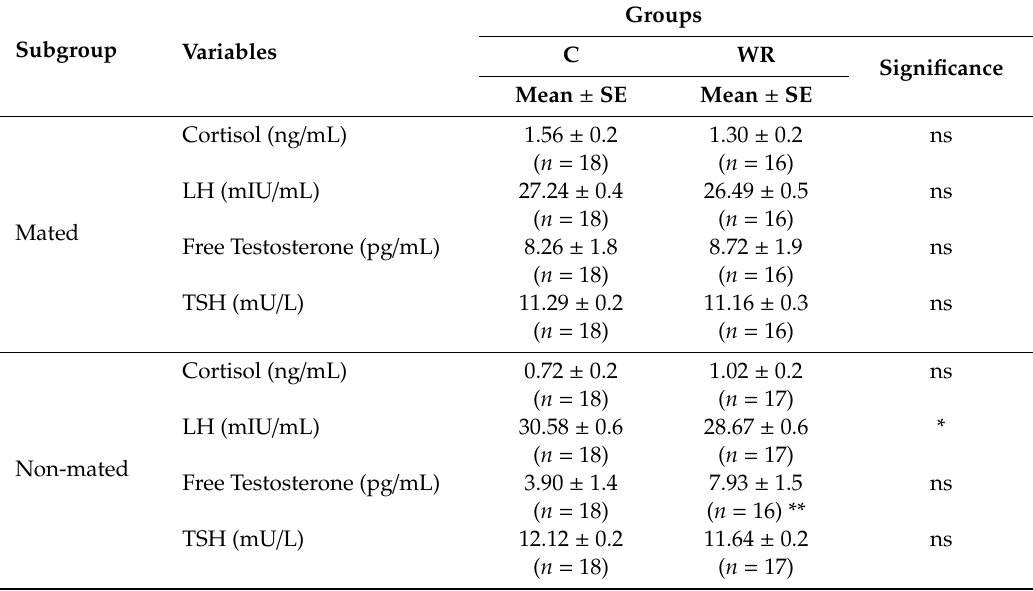
Table 4. Reproductive hormone levels of mated and non-mated F1 male rat o ff spring in each group.